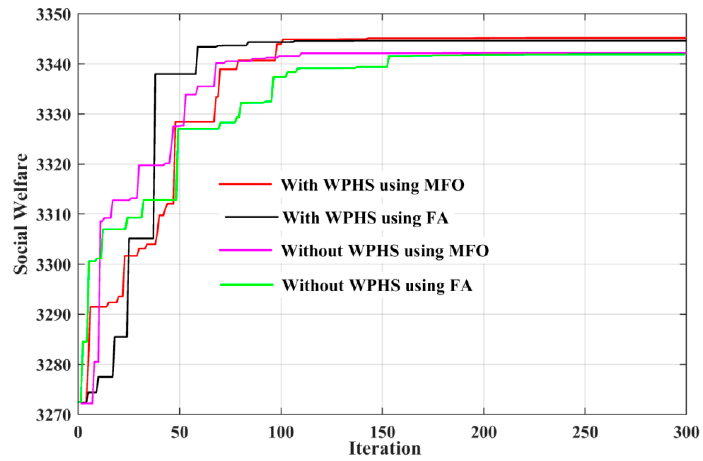
Figure 11. Comparative convergence characteristics.